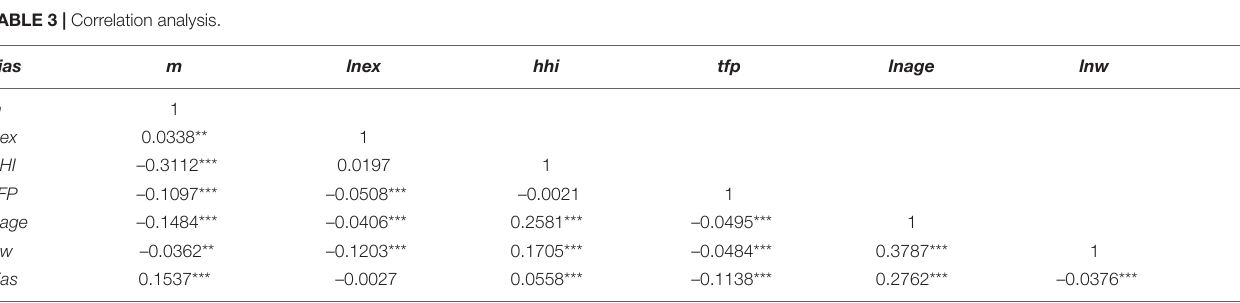
FIGURE 1 | Histogram of technical change bias index of Chinese listed manufacturing enterprises from 2012 to 2019. TABLE 3 | Correlation